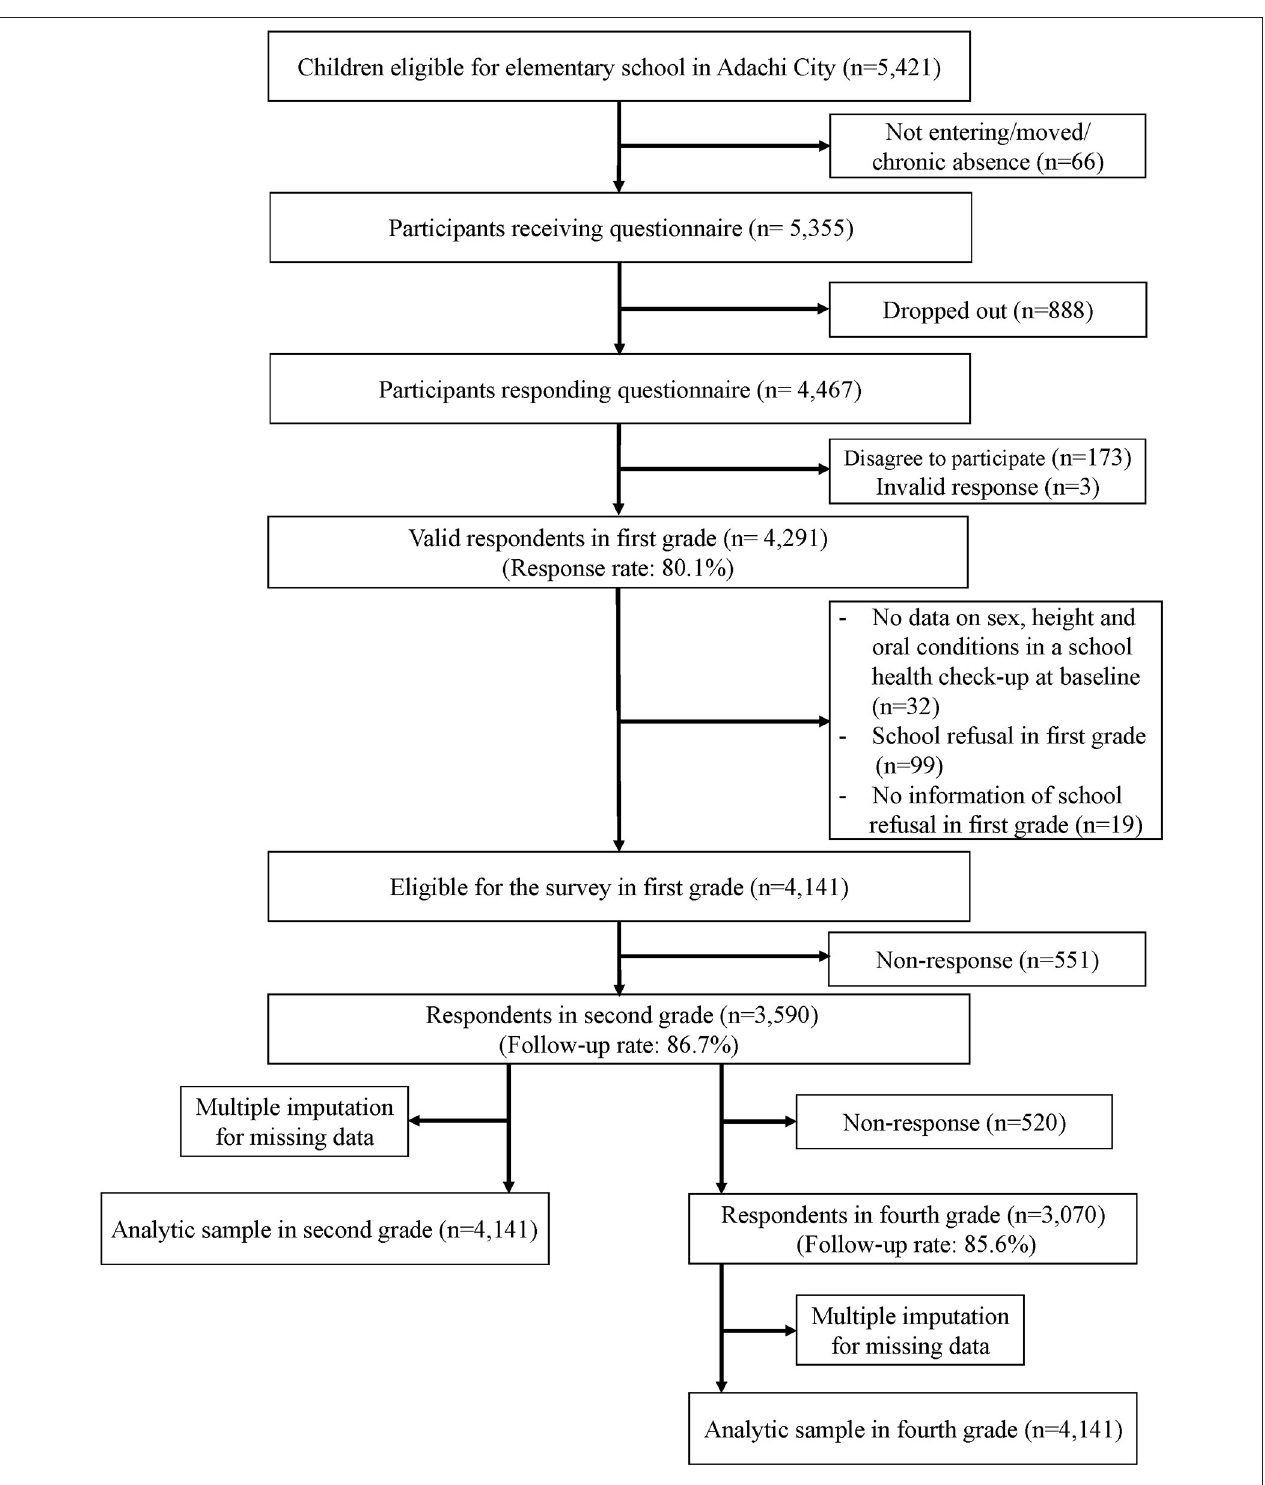
FIGURE 1 | Flow chart of